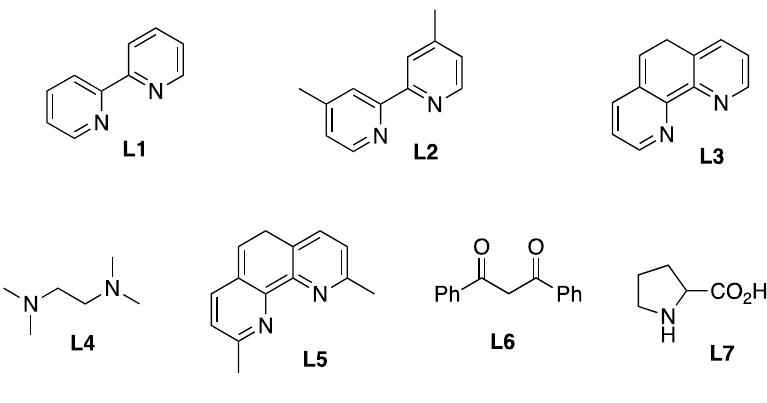
Figure 1. Ligands used in Table 1.